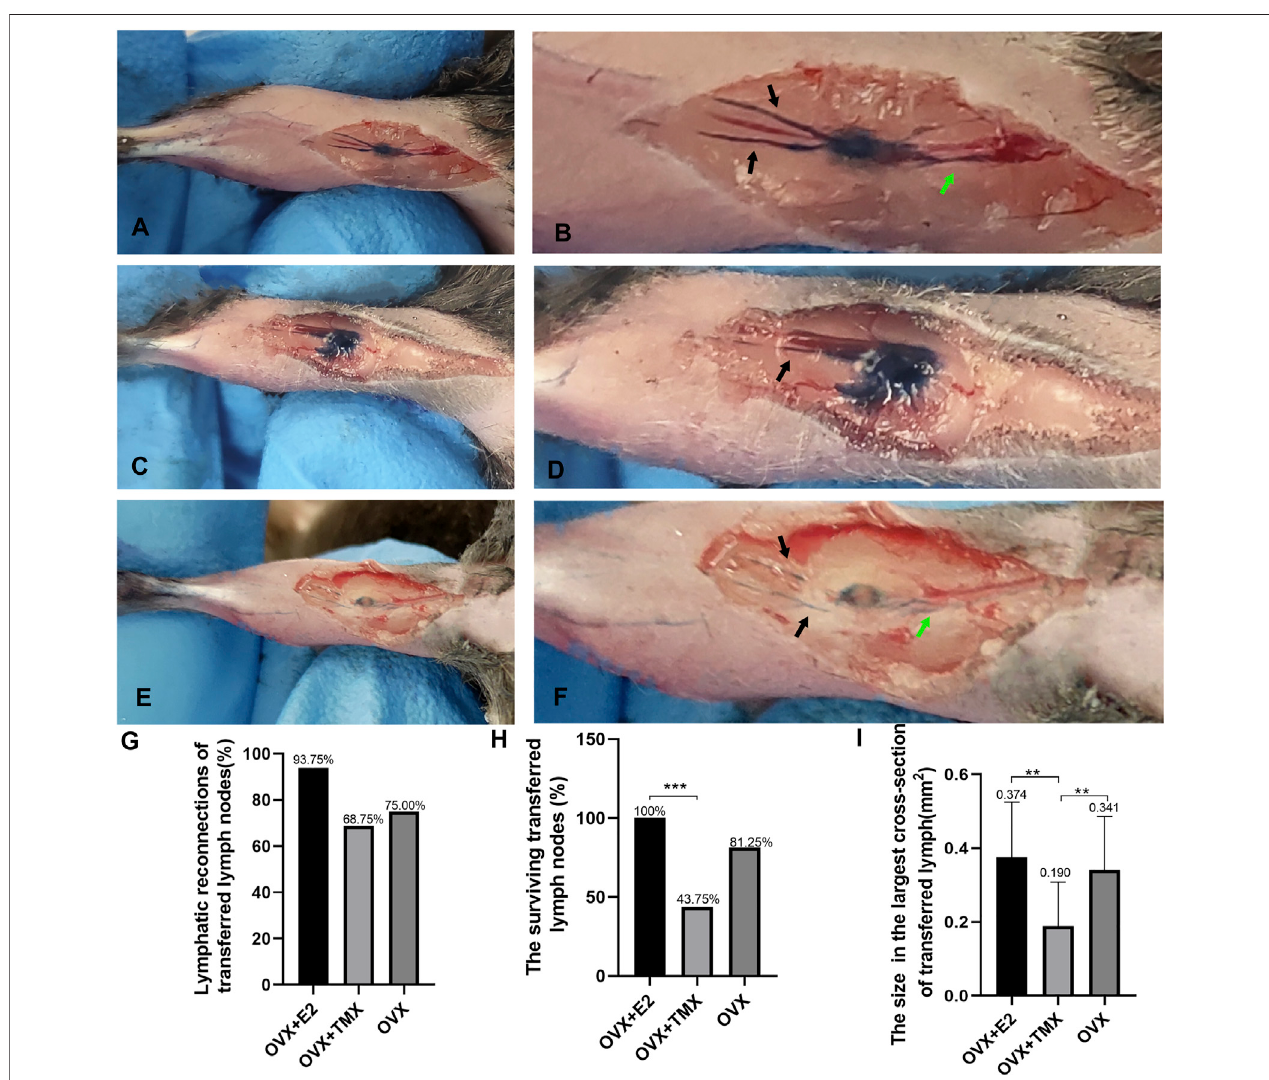
FIGURE 1 | Validation of the experimental model with drug administration and the observation of the reconnections between lymphatic vessels and transferred lymph nodes. (A,B) Example of the reconnection between lymphatic vessels and lymph nodes. (C,D) Reconnections between lymph nodes with afferent and efferent lymphatics were not fully established and leakage exists. (E,F) Reconnection between lymphatic vessels and lymph nodes in the OVX + TMX group. Stained afferent lymphatic vessels (black arrows) and efferent lymphatic vessels (green arrows). (G) Quanti fi cation of lymphatic reconnections of three groups. (H) Quanti fi cation of surviving transferred lymph nodes of three groups. (I) Average sizes of transferred PLNs in each group in the largest cross sections. * p < 0.05, ** p < 0.01, *** p < 0.001.